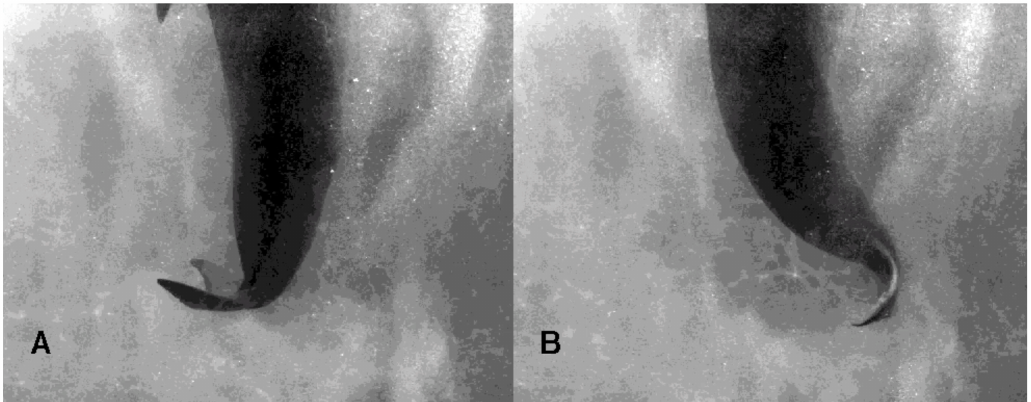
Figure 2. Spanwise bending of the flukes in mid-stroke ( A ) and chordwise bending of the flukes at the end of the stroke ( B